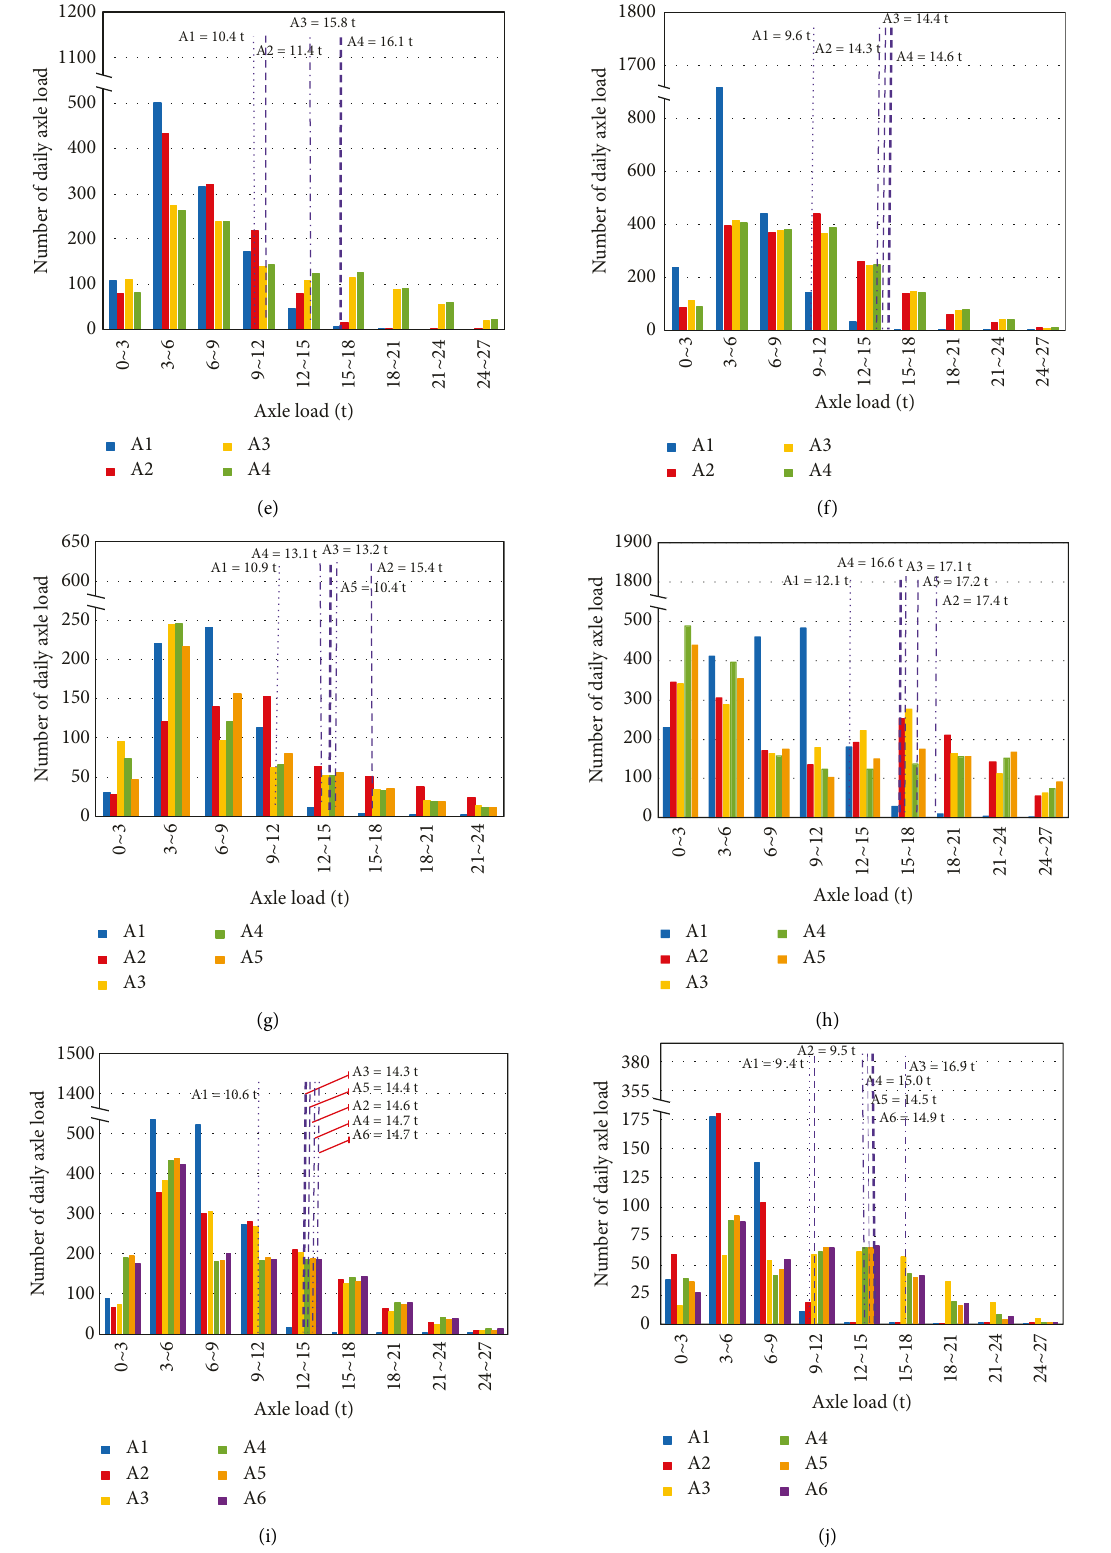
Figure 8: Axle load and equivalent axle load of the vehicle. (a) Axle loads and equivalent axle loads of the V 2 vehicle type. (b) Axle loads and equivalent axle loads of the V 3 vehicle type. (c) Axle loads and equivalent axle loads of the V 4 vehicle type. (d) Axle loads and equivalent axle loads of the V 5 vehicle type. (e) Axle loads and equivalent axle loads of the V 6 vehicle type. (f) Axle loads and equivalent axle loads of the V 7 vehicle type. (g) Axle loads and equivalent axle loads of the V 8 vehicle type. (h) Axle loads and equivalent axle loads of the V 9 vehicle type. (i) Axle loads and equivalent axle loads of the V 10 vehicle type. (j) Axle loads and equivalent axle loads of the V 11 vehicle